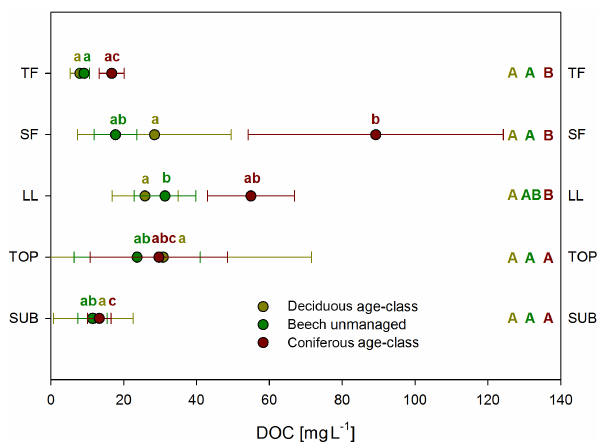
Figure 1. Mean DOC concentrations in ecosystem fluxes (TF, SF, LL, TOP, SUB) grouped according to management categories (deciduous age class, beech unmanaged, coniferous age class). Whiskers show standard deviations. TF: throughfall, n = 201, 224, 244; SF: stemflow, n = 140, 207, 140; LL: litter leachate, n = 179, 199, 203; TOP: topsoil solution, n = 60, 87, 47; SUB: subsoil solu- tion, n = 63, 56, 65. Capital letters (reading horizontally): differ- ences between management categories; lowercase (reading verti- cally): differences between water samples collected from different ecosystem fluxes within the same management category.